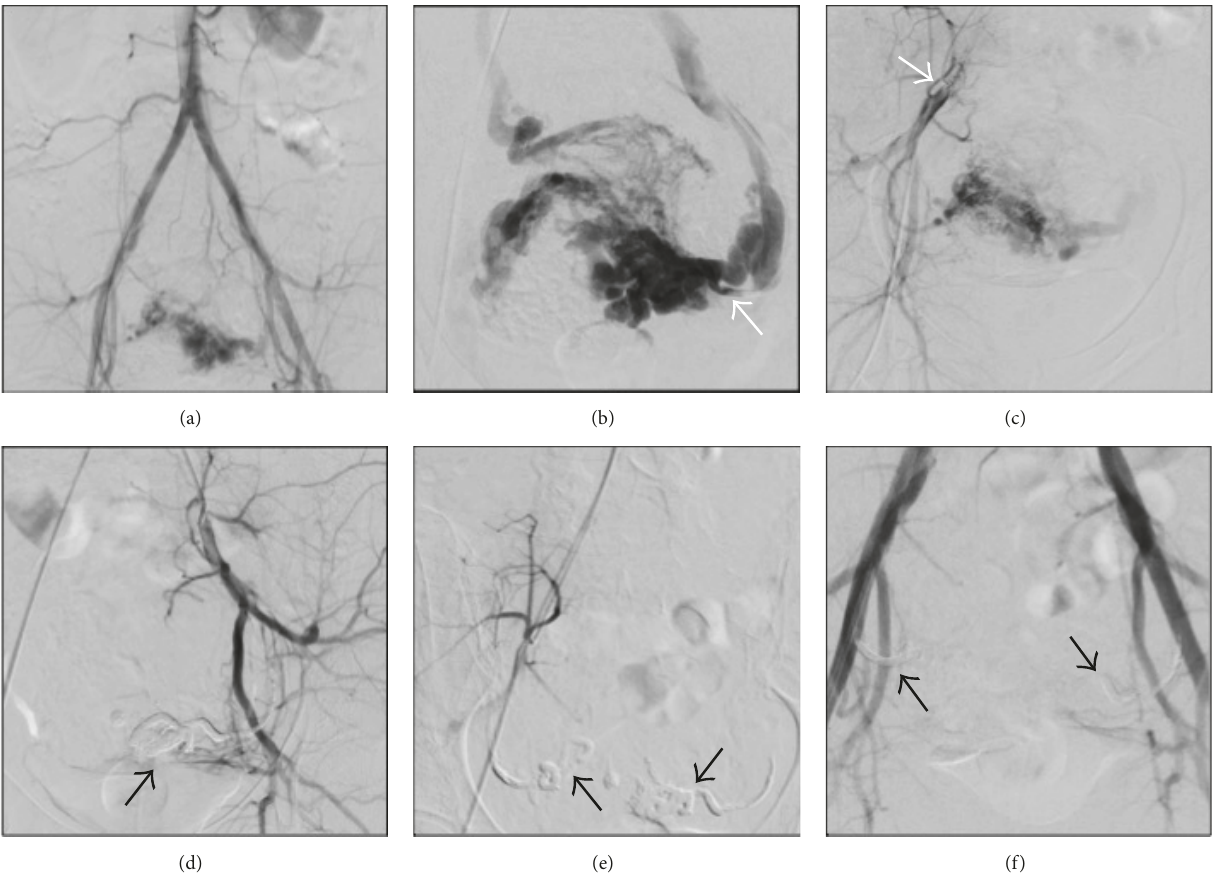
Figure 2: Procedural imaging and digital subtraction angiography. (a) Pelvic angiogram after 5Fr pigtail catheter positioning in abdominal aorta showing the vascular lesion in arterious phase injection. (b) Selective left uterine arteriography by 5Fr Cobra catheterization positioned crossing the aortic carrefour (white arrow): ectatic and aberrant arterious vessels with concomitant ectatic and serpiginous direct venous outflow, confirming the AVF diagnosis. (c) Selective right uterine arteriography by 5Fr Robert Uterine Curve catheterization (white arrow): involvement of the right uterine artery in terms of inflow to the AVF. ((d) and (e)) Left and right postembolization hypogastric artery angiography, respectively: complete occlusion of the uterine arteries after Onyx-18 injection and preservation of the other hypogastric branches; the Onyx-18 cast is indicated by the black arrows. (f) Final pelvic angiogram: the AVF is no more appreciable after embolization with Onyx-18 (black arrows indicate the